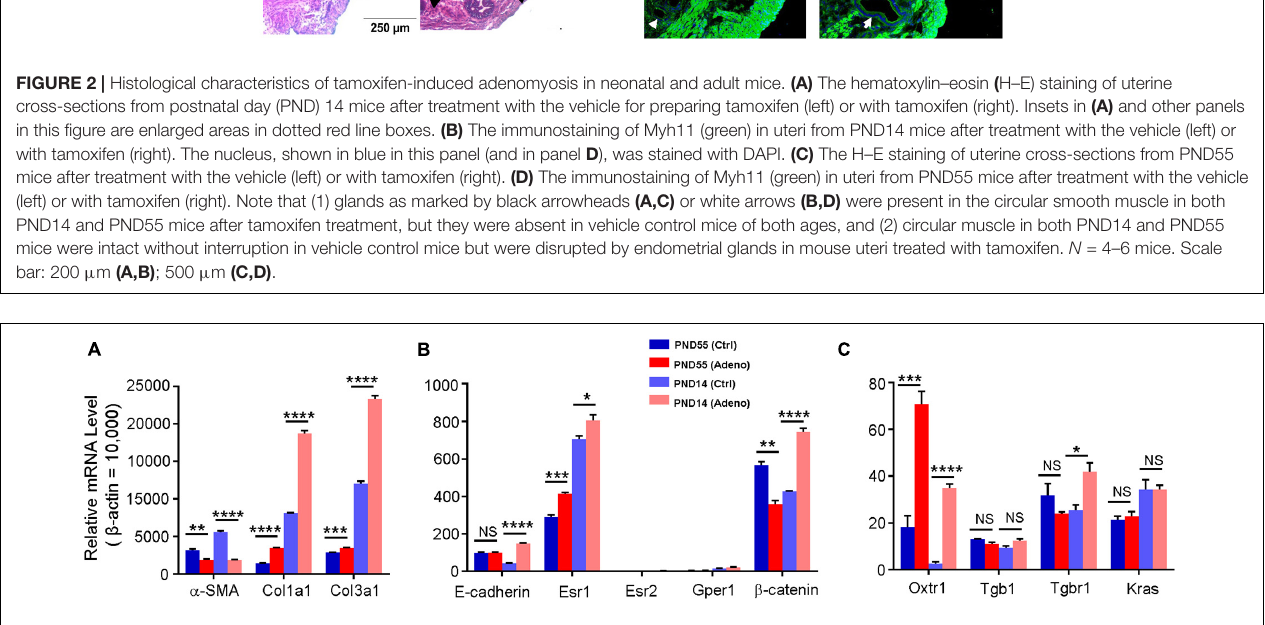
( Figure 3B ). Oxytocin receptor was increased by 3.34 ± 0.89